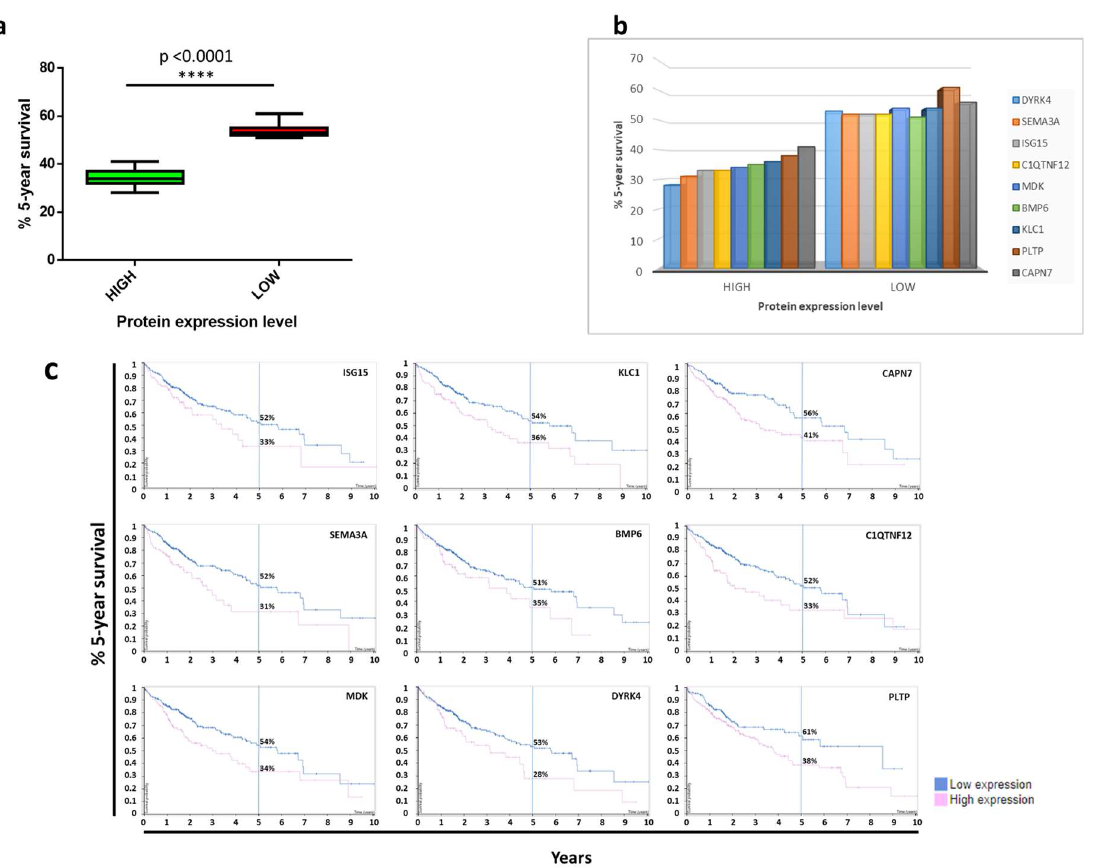
Figure 2. Survival analysis: ( a ) the % 5-year survival average in HCC patients with high or low